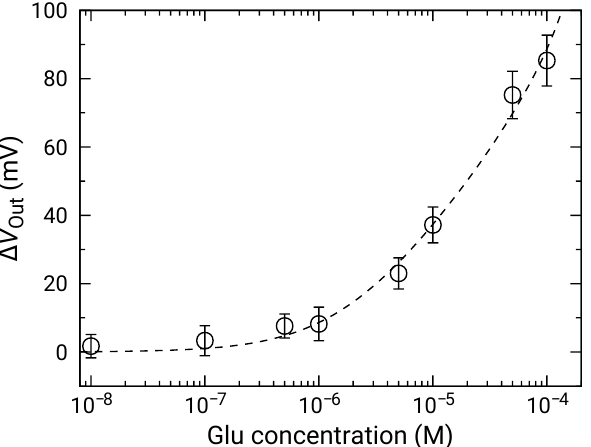
Figure 11. Concentration dependence of sensor output change for Glu addition. Data are plotted after subtracting ∆ V Out for 0 M Glu (control) to compensate for output